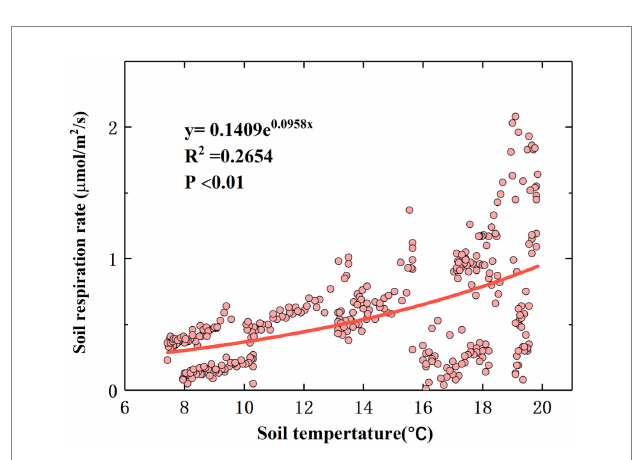
FIGURE 4 Relationship between R S and soil